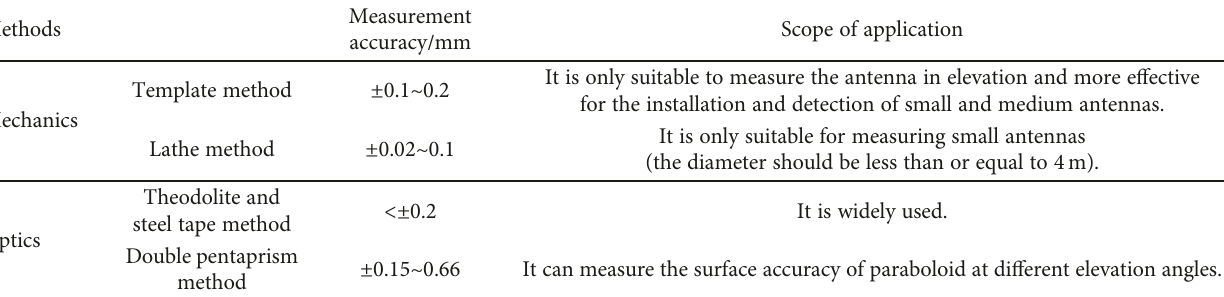
Table 1: Traditional methods of antenna surface measurement.